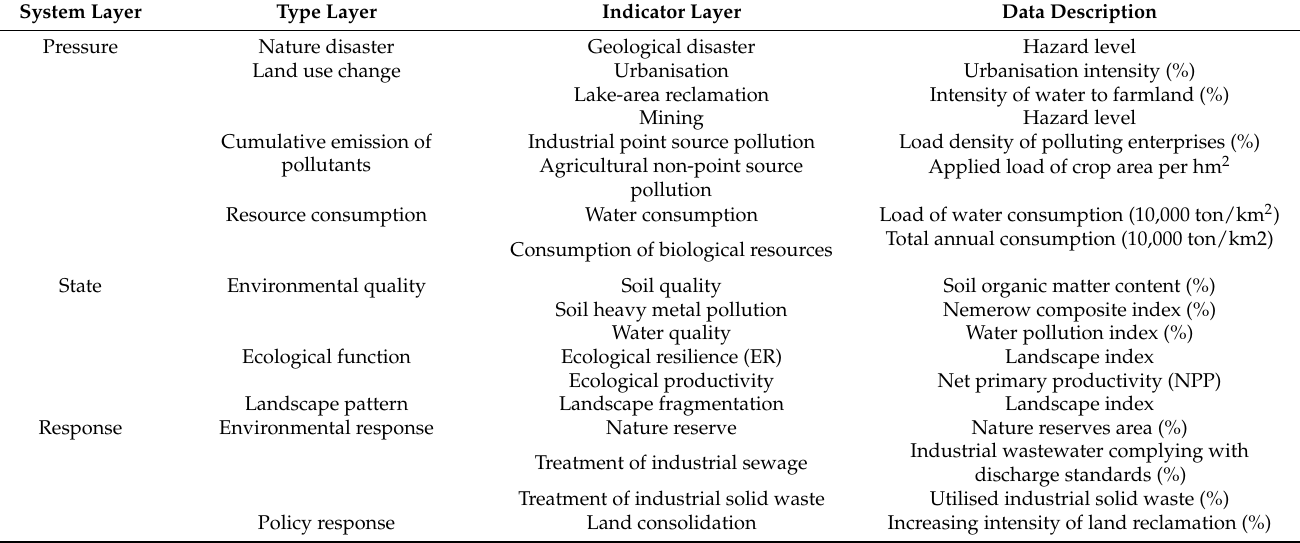
Table 1. Indicator system of regional land eco-security on the Daye area.